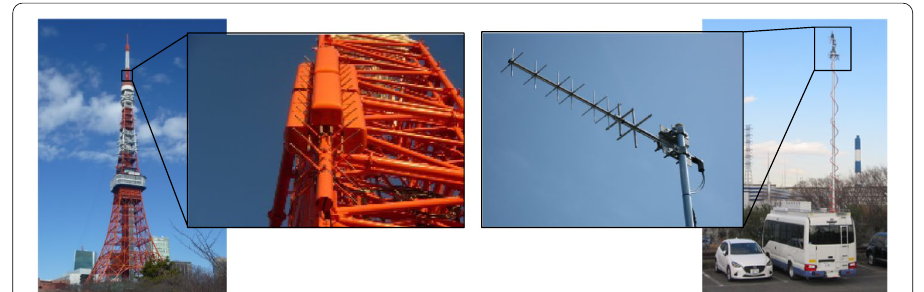
Fig. 4 Transmitting antenna (left) and receiving antenna (right) used for field experiments